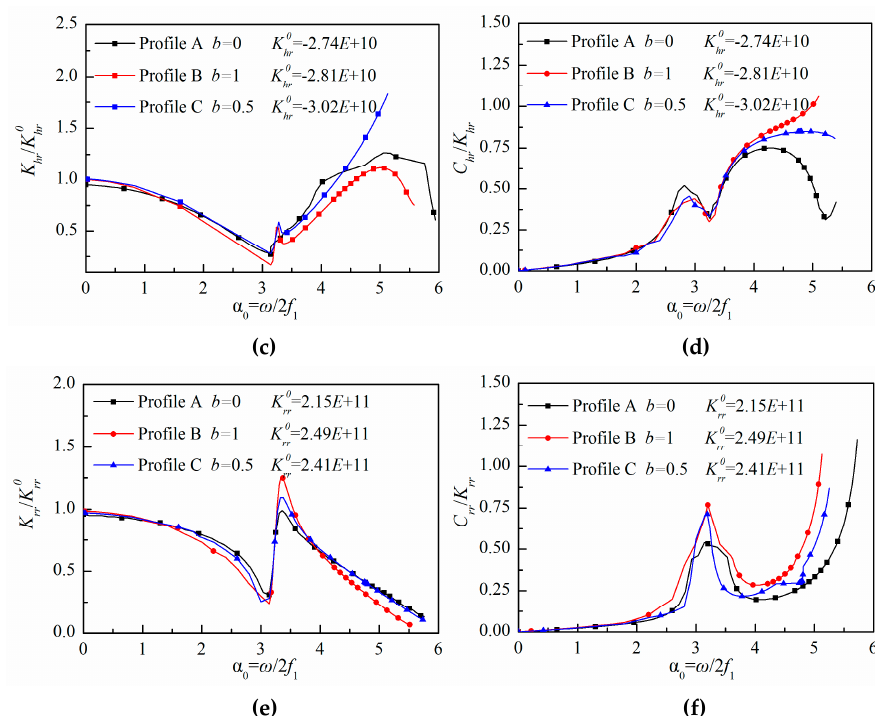
Figure 15. Variation of three dynamic stiffness coefficients with respect to the dimensionless frequency under the effect of the multi-layer soil stiffness for WSBF with diameter 45 m: ( a ) Horizontal stiffness coefficient; ( b ) horizontal damping coefficient; ( c ) coupling stiffness coefficient; ( d ) coupling damping coefficient; ( e ) rocking stiffness coefficient; ( f ) rocking damping coefficient.